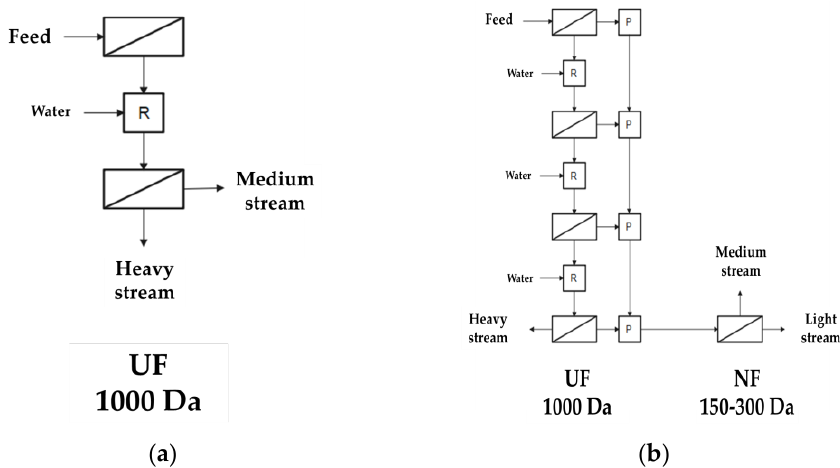
Figure 6. ( a ) Single diafiltration with ¼ of removed water; ( b ) triple diafiltration with complete water replacement.